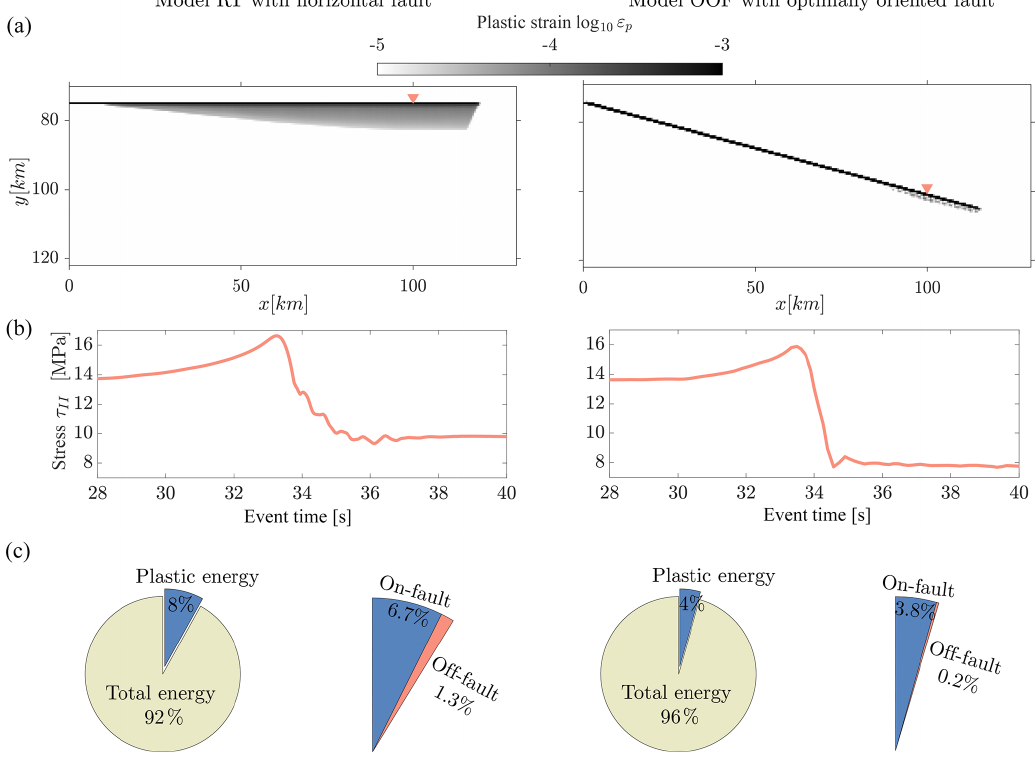
Figure 8. Comparison of plastic off-fault strain and energy between model RT and OOF (optimally oriented fault model). (a) Accumulated plastic off-fault strain for both models in grayscale during the first earthquake. Red triangles indicate the sample location of the stress data plotted in (b) . Panel (c) shows the ratio of the plastic energy to the total energy in percentage. The plastic energy is subdivided into an on-fault (blue) and an off-fault (red)